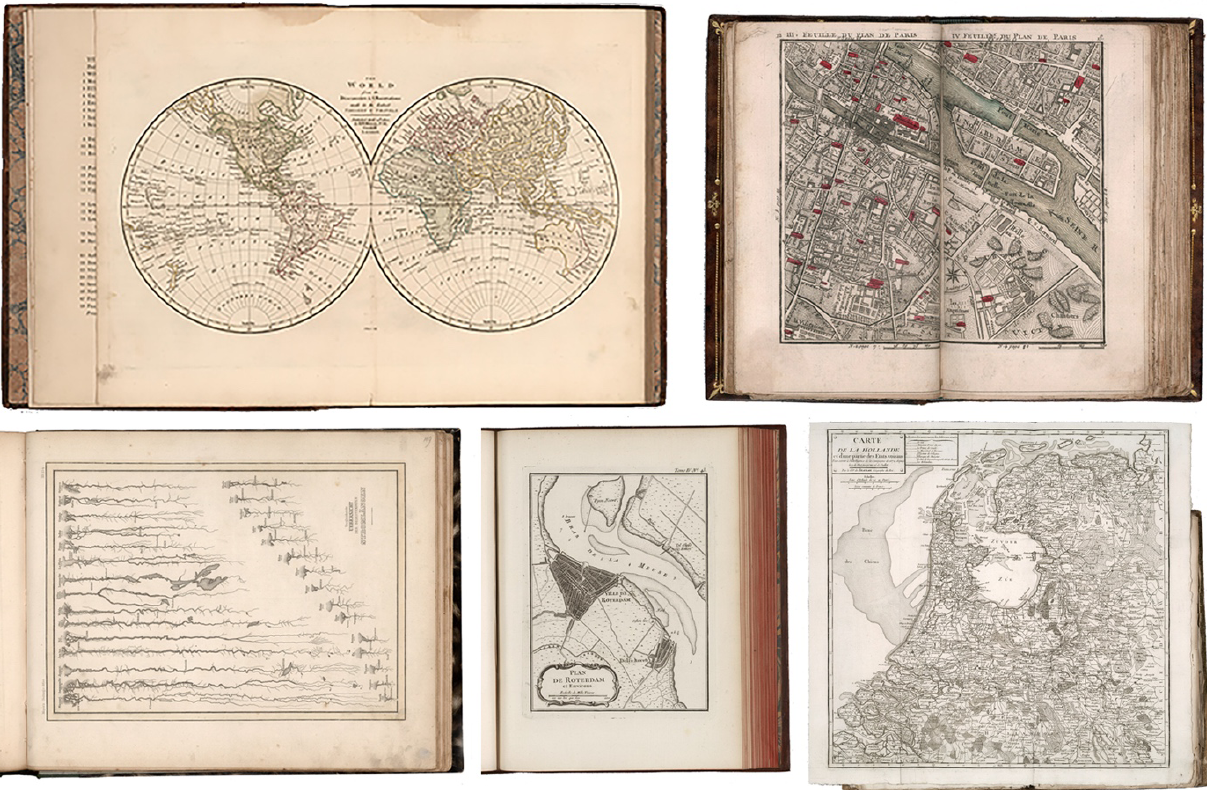
Figure 1. Examples of old maps. Top, from left to right: The World from the Discoveries & Observations Made in the Latest Voyages & Travels (Wilkinson, 1809); IIIe. Feuille du Plan de Paris. IVe. Feuille du Plan de Paris (Denis & Pasquier, 1765). Bottom, from left to right: Vergleichende Uebersicht der bedeutendsten Stromlängen (Meyer, 1852); Plan de Rotterdam